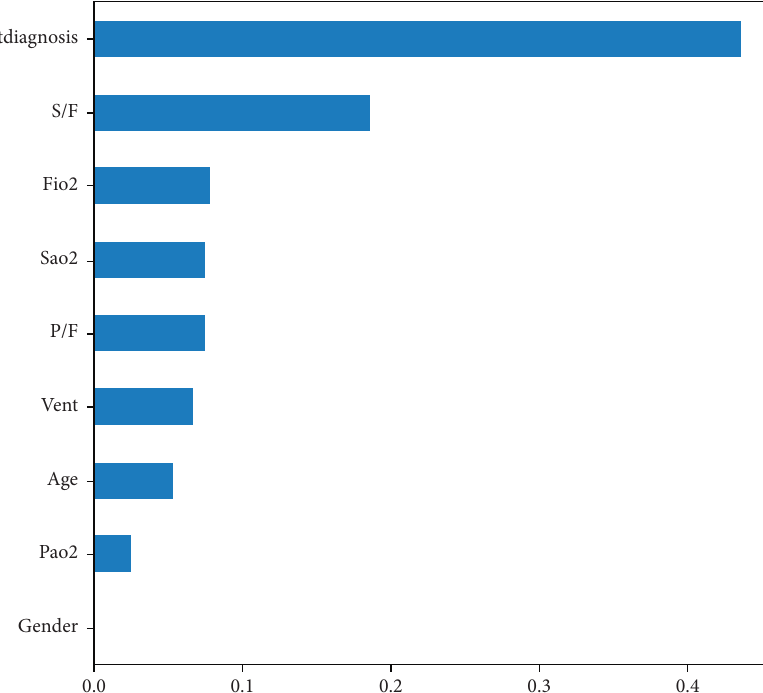
Figure 5: Feature importance ranking via the XGBoost built-in method. PaO 2 : partial pressure of oxygen; FiO 2 : fraction of inspired oxygen; SaO 2 : oxygen saturation; P/F: PaO 2 and FiO 2 ratio; S/F: SaO 2 and FiO 2 ratio; Vent: mechanical ventilation.